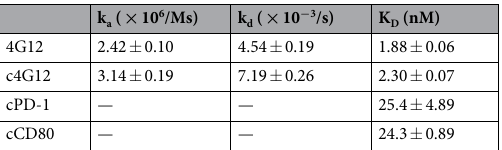
Table 1. Binding properties of mAbs and recombinant receptors to cPD-L1-His. The equilibrium dissociation constant (K the table are means ± SE of three independent experiments. k a , association rate constant; k d , dissociation rate